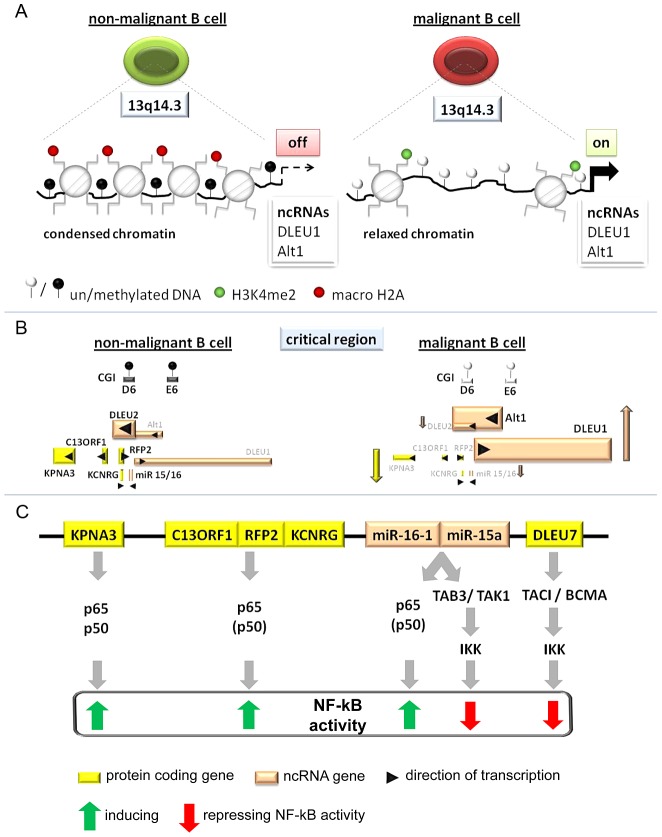
Model of the tumor suppressor mechanism localized in 13q14.3.(A) Regions in CpG islands D and E that are DNA-methylated in non-malignant B-cells (left) become demethylated in the vast majority of CLL patients (right). This coincides with relaxed chromatin characterized by absence of macroH2A and enrichment of H3K4me2 at the promoters of the lncRNA genes DLEU1 and DLEU2/Alt1. (B) DNA-hypomethylation is correlated with transcriptional upregulation of splicing variants of the two lncRNA genes DLEU1 and DLEU2 and inversely correlated with the protein-coding genes in 13q14.3. No correlation could be found with levels of mature miR-15a and miR-16, probably because these transcripts are also deregulated by a posttranscriptional processing defect in CLL cells (Allegra, manuscript submitted). (C) Candidate genes localized in the critical region in 13q14.3 are functionally related and all modulate NF-kB signalling, albeit with different impact. Nuclear transporter KPNA3 is binding NF-kB components p65 and p50 and is therefore likely a positive regulator like e.g. RFP2. RFP2 binds to C13ORF1 and induces NF-kB activity via the canonical pathway components p50 and p65, for which its ubiquitin ligase actvity is required. The miRNA genes miR-15a and miR-16-1 were identified together with other members of this miR family to be among the strongest activators of NF-kB activity. Previously they have been shown to both modulate cell cycle regulators and inhibit NF-kB via TAB3/TAK1. DLEU7 has recently also been reported to inhibit NF-kB by binding and inactivating the TACI/BCMA receptors.